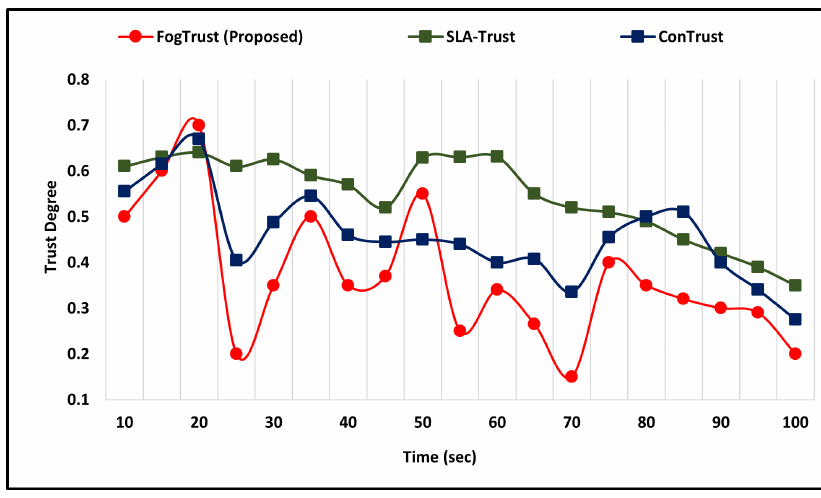
Figure 4. Comparative Analysis of FogTrust Against On-off Attacks.